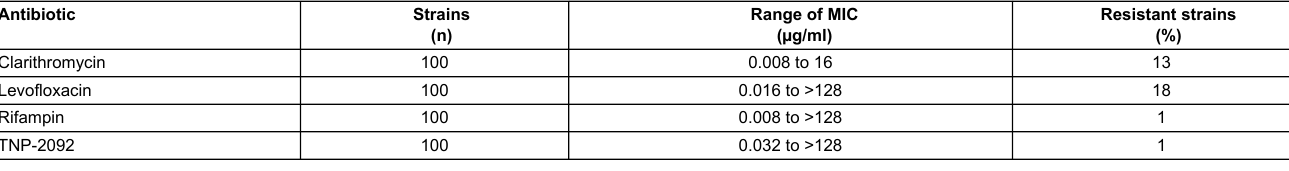
Table 1: Resistance percentages and minimum inhibitory concentrations (MICs) of four antibiotics against H. pylori strains.